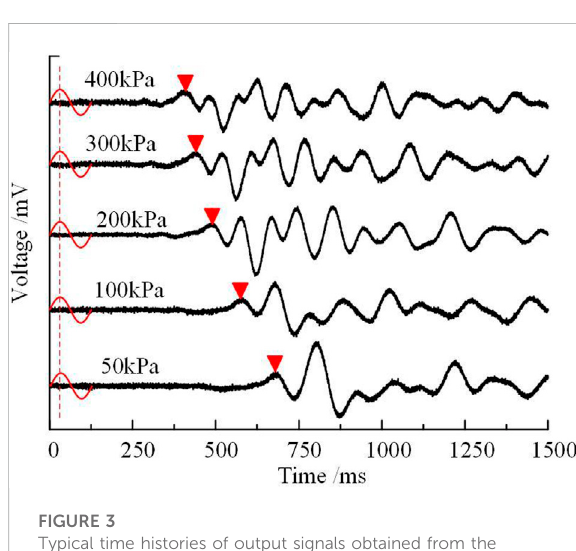
FIGURE 3 Typical time histories of output signals obtained from the bender element